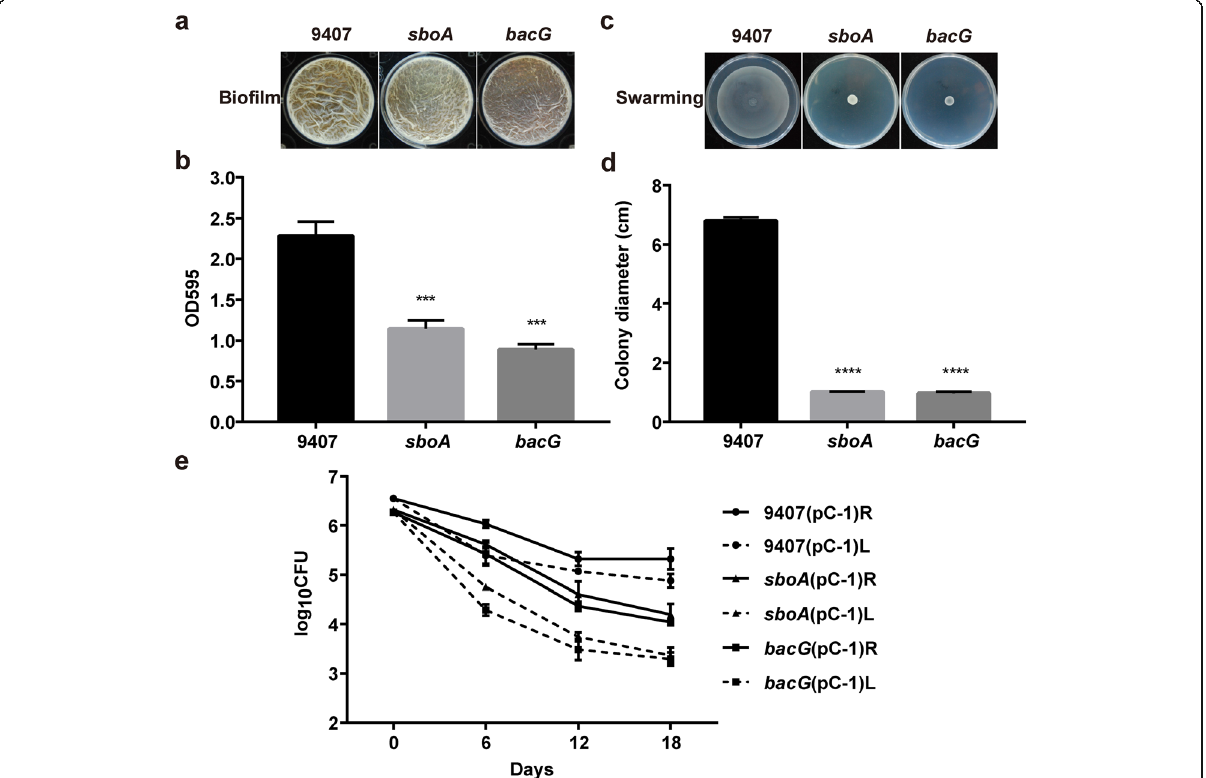
Fig. 5 The impact of deleting sboA or bacG on colonization ability of the B. subtilis 9407 strain. a, b Biofilm formation assays. Biofilm assays were detected in Msgg plate incubated at 28 °C for 96 h. c, d Swarming ability assays. Swarming assays were detected in LA plate (containing 0.7% agar) incubated at 37 °C for 6 h. After drying the water, the plates were incubated overnight at 37 °C. e Colonization on the melon roots (R) and leaves (L) of B. subtilis 9407 and mutant strains. To facilitate the screening, all these strains were transformed into a plasmid pC-1 with a chloramphenicol resistance gene. The y-axis was log 10 CFU and the x-axis was the number of days. The statistical analysis was performed using GraphPad Prism 7 software by one-way ANOVA with the Dunnett test ( P < 0.05). The variation was recorded as mean ± SE (****: P < 0.0001, ***: